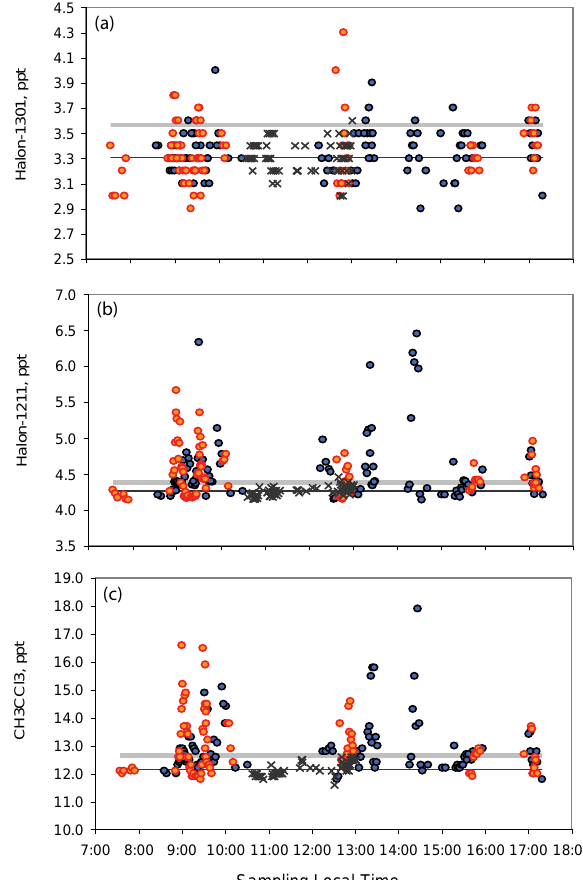
43 Fig. 4. Mixing ratio of (a) Halon-1301, (b) Halon-1211, (c)